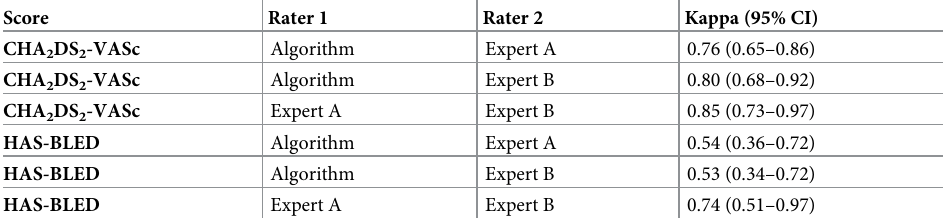
Table 3. Inter-rater agreement statistics for CHA 2 DS 2 -VASc and HAS-BLED risk